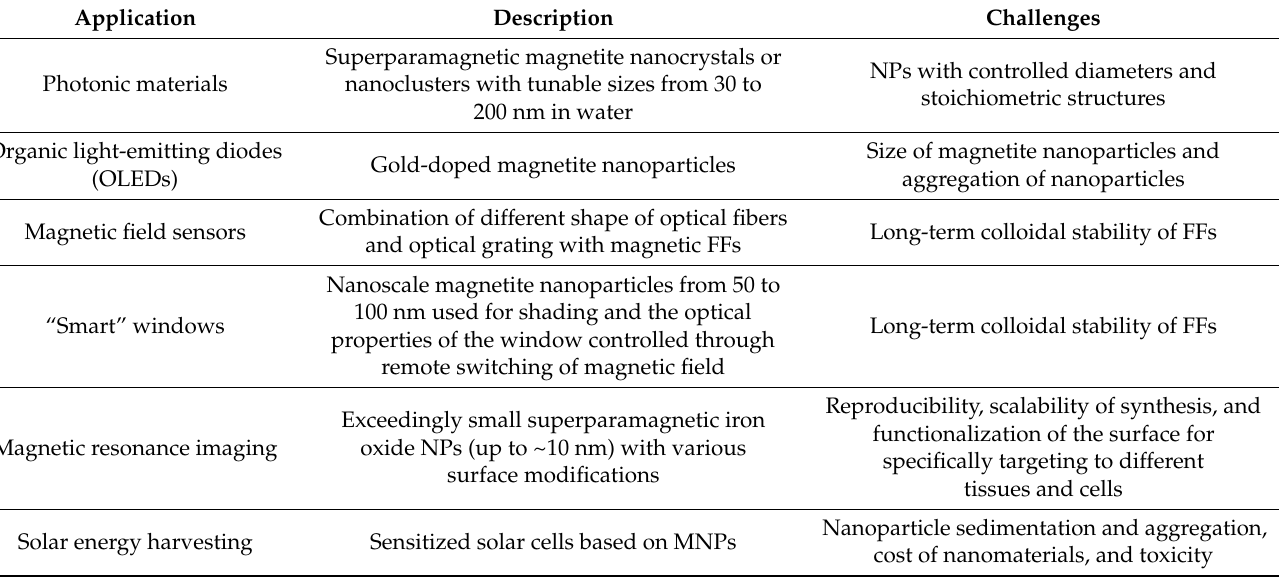
Table 3. Magnetic ferrofluids (FF) applications, descriptions, and challenges in optics and